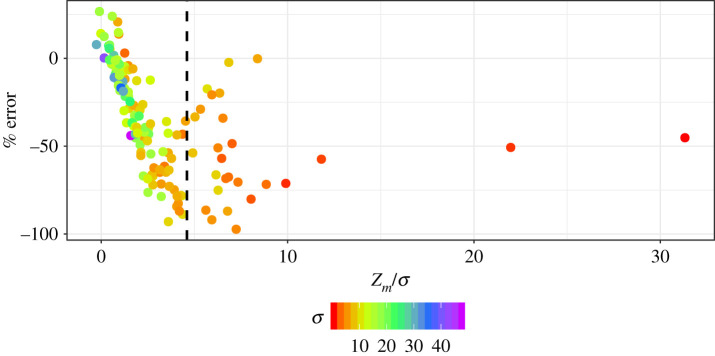
The per cent difference between model estimates of integrated primary production using a non-uniform and a uniform (surface chlorophyll concentration is held constant with depth) chlorophyll profile plotted against the depth of the subsurface chlorophyll peak divided by the peak width (zm/σ). Points are coloured according to their corresponding σ value. (Online version in colour.)